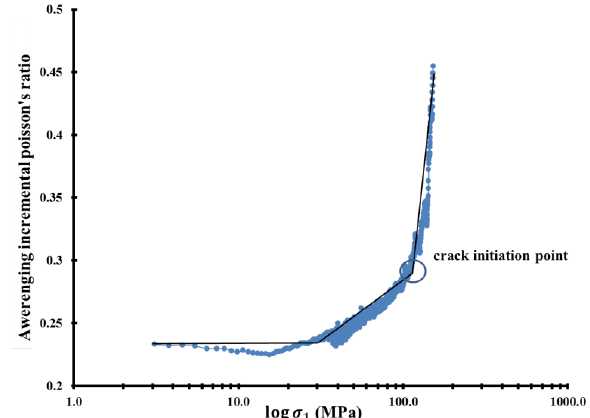
Fig. 7. Poisson’s ratio method for crack initiation threshold determination for Hungarian granitic Figure 7: Poisson’s ratio method for crack initiation threshold rock sample (uniaxial compression case) determination for Hungarian granitic rock sample (uniaxial compression case).